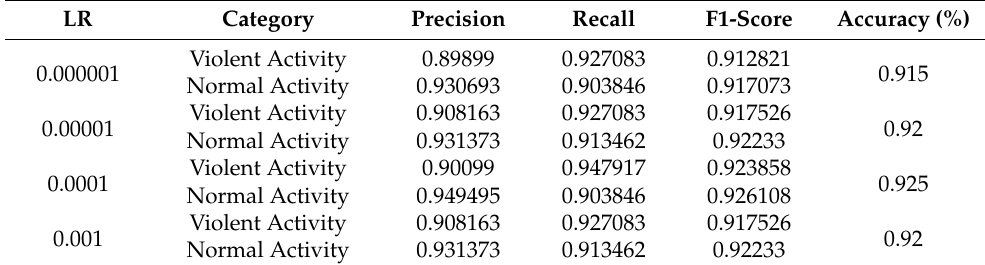
Table 10. A detailed summary of the tesidual LSTM architecture.